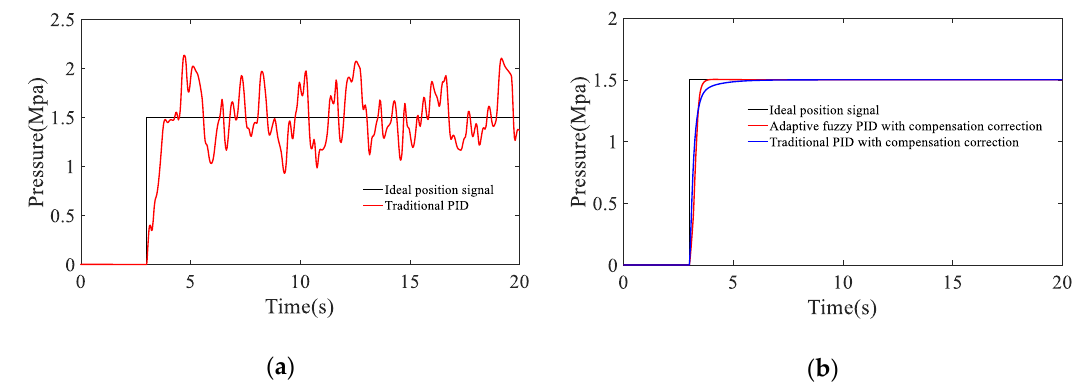
Figure 9. Step signal response curve: ( a ) Traditional PID; ( b ) Traditional PID with compensation correction and adaptive fuzzy PID with compensation correction.